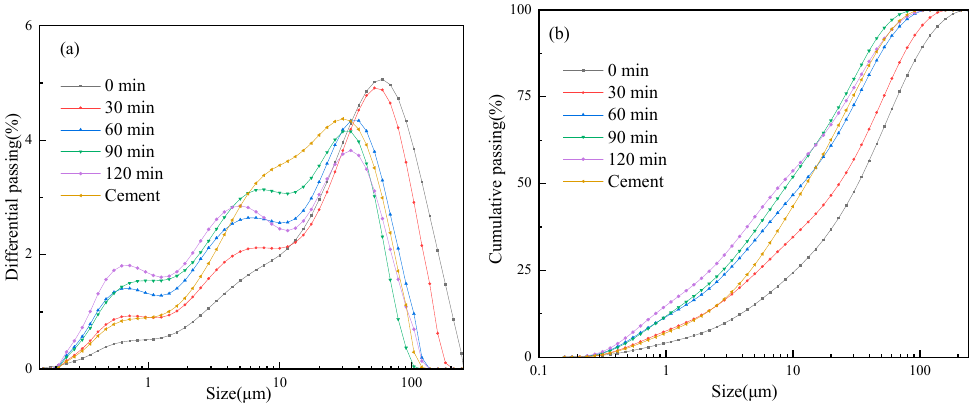
Figure 2. Particle size distribution of cement and copper slag with different grinding times. ( a ) Differential passing; ( b ) cumulative passing.